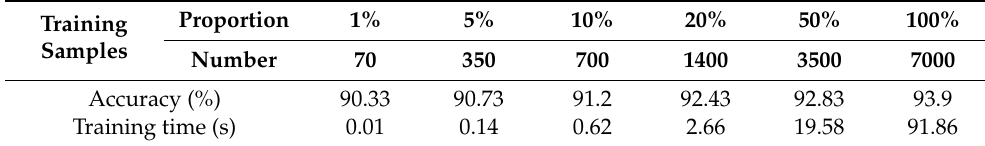
Table 4. Diagnosis accuracy and training time of FDFM under different sample proportions.